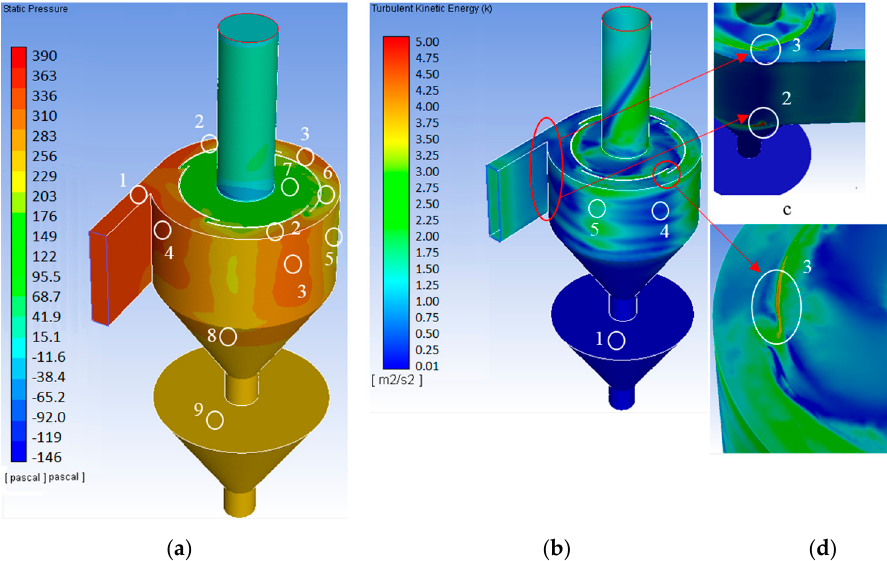
Figure 7. The distribution of the gas flow’s static pressure ( a ) and the kinetic energy of the turbulence ( b ) along the walls of the multi ‐ channel cyclone’s separation chamber; ( c ) is the gas flow inlet and the detailed representation of the cyclone channel 1; ( d ) is a detailed representation of the gas flows’ redistribution near the inlet to channel 3 of the cyclone; the area at the beginning of the channel (point 1), the midpoint of channel 1 to the end of channel 4 (point 2), at the beginning of each channel (point 3), at the beginning of channel 2 and at the end of the channel 4 (point 4), in the middle of channel 3 (point 5), the top cover of the separation chamber in channels 2 and 3 (point 6), in the central internal channel (point 7), the area of the first cone ‐ shaped part (point 8), the second (lower) cone ‐ shaped part (point 9)